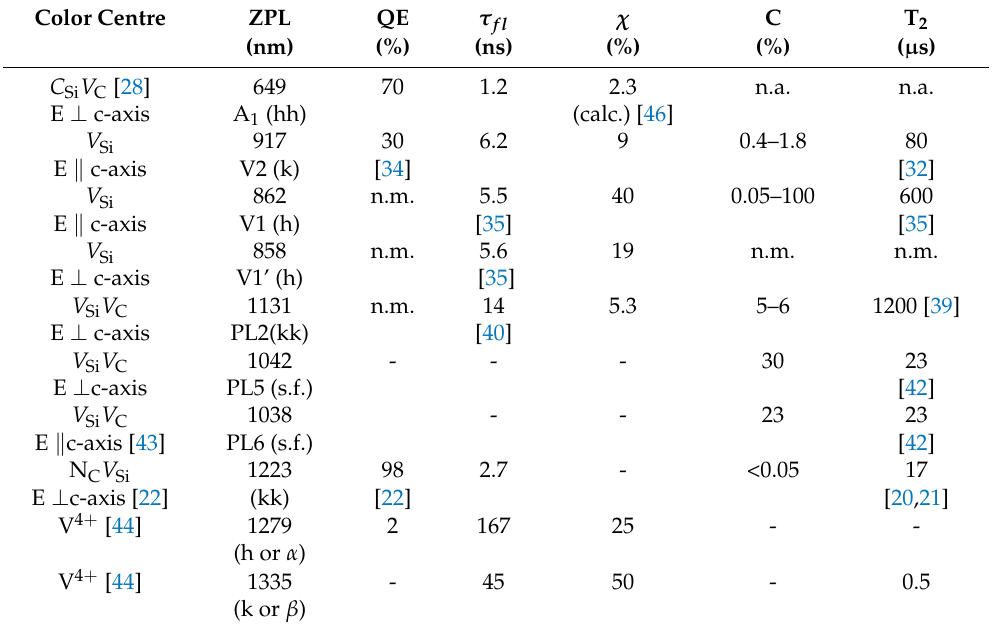
Table 1. Color centres in 4H-SiC zero phonon line (ZPL), the quantum efficiency (QE), and their optical and spin properties relevant for quantum technologies. Other relevant properties for the aforementioned applications such as the optical transition fluorescence lifetime ( τ fl ), optical spin-read out contrast (C), spin coherence time ( T 2 ) are also listed. n.m. stands for not measured and n.a. for not available, s.f. stacking faults. The gyromagnetic ratio g e = 2.0028 for the V Si [45]. Color Centre ZPL QE τ fl χ